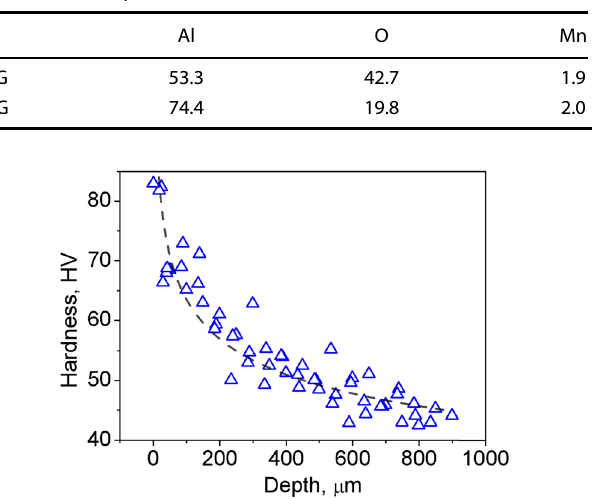
Fig. 6 Hardness-depth pro fi le. Hardness results of GG Al – Mn